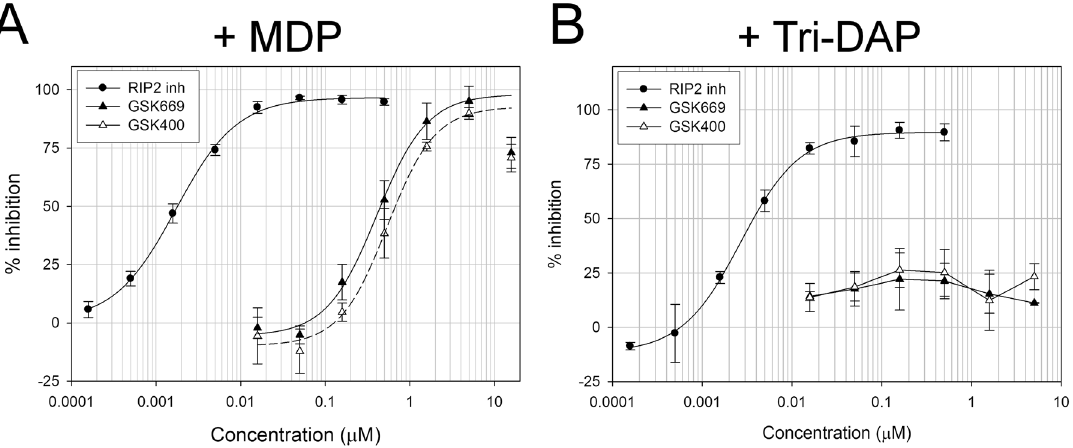
Figure 3. GSK669 exhibits NOD2 selectivity in cells that express endogenous NOD1 and NOD2. Concentration response curves of GSK669 and its close analogue GSK400 for the inhibition of MDP (A) but not Tri-DAP (B) stimulated IL-8 secretion in HCT116 cells which express functionally active NOD1 and NOD2. Cells were pre-incubated with compounds for 1 hour prior to addition of NOD agonists. IL-8 secreted into medium was assayed after 24 hours. The same RIP2 inhibitor used in Figure 2C was included as a positive control. Data are the average percent inhibition obtained from 1 (RIP2), 2 (GSK400) or 4 (GSK669) separate experiments.